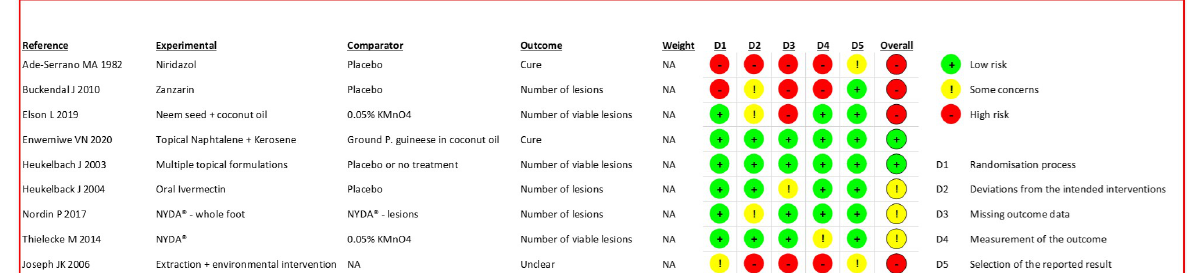
Fig 3. Graphic presentation of the quality evaluation of included clinical trials using the Revised Cochrane Risk of Bias Tool for Randomized Trials.